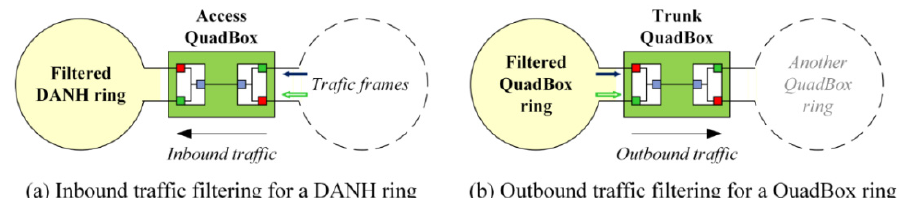
Figure 4. The process of filtering unicast